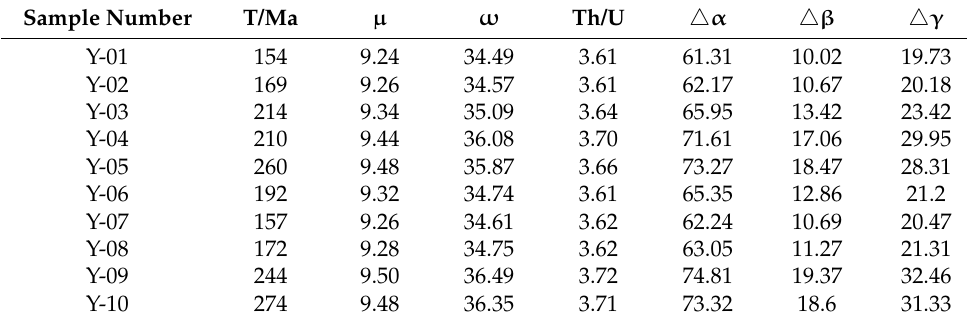
Table 8. Lead isotopic characteristics of metallic sulfides in the Jilinbaolige deposit.